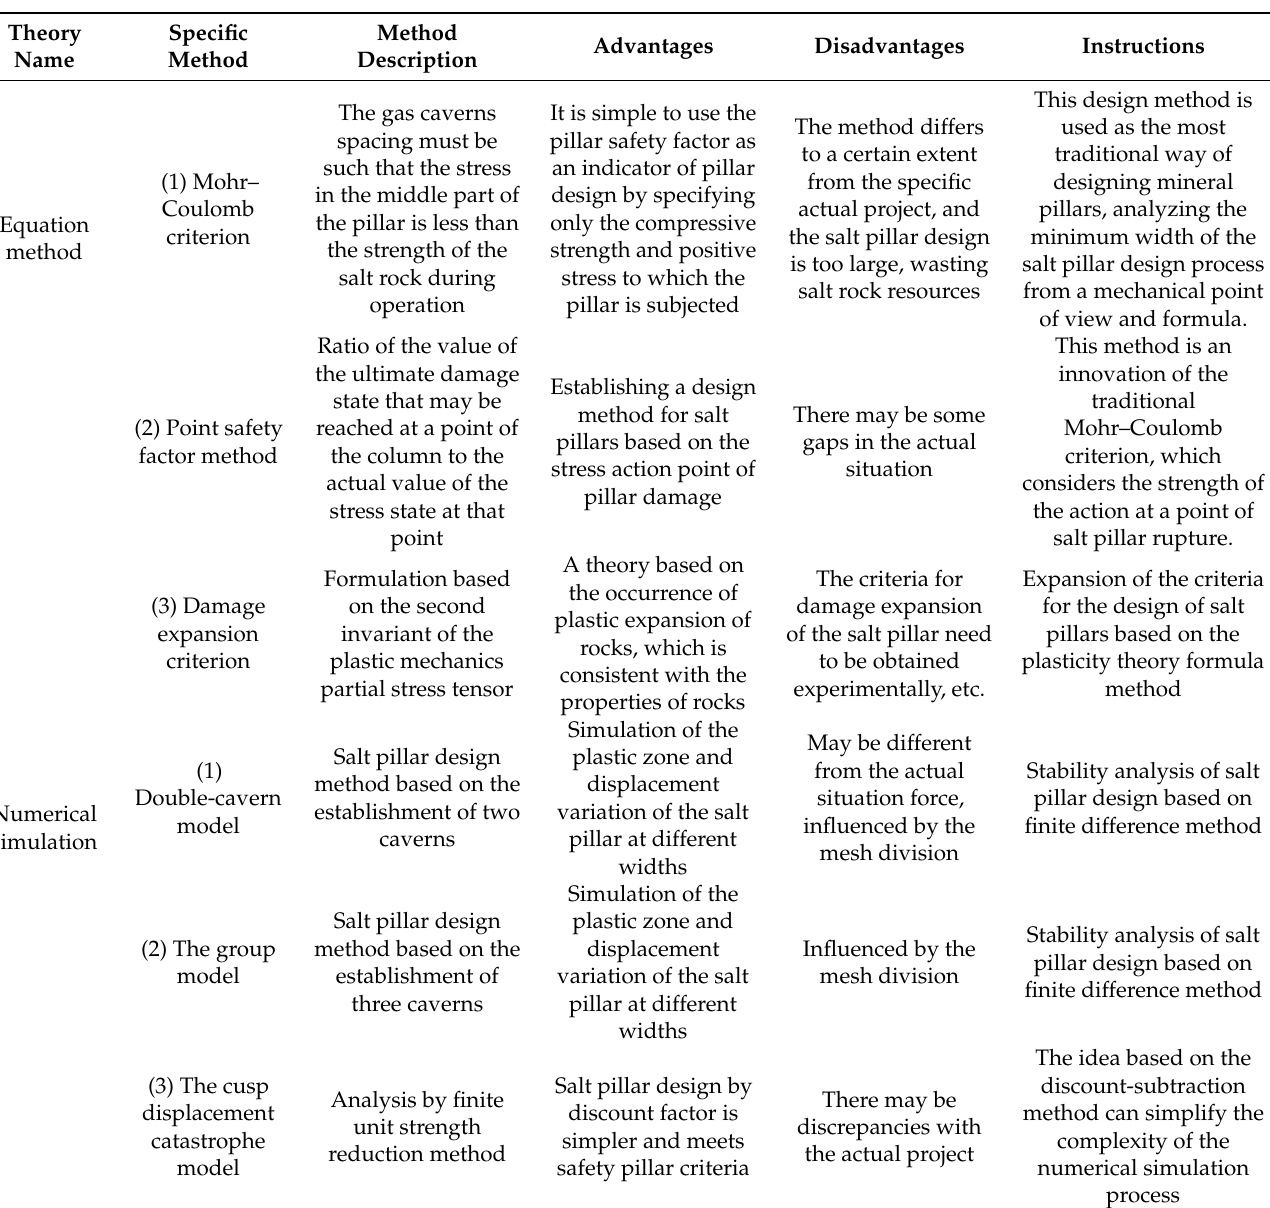
Table 4. Comparison of different mine pillar design